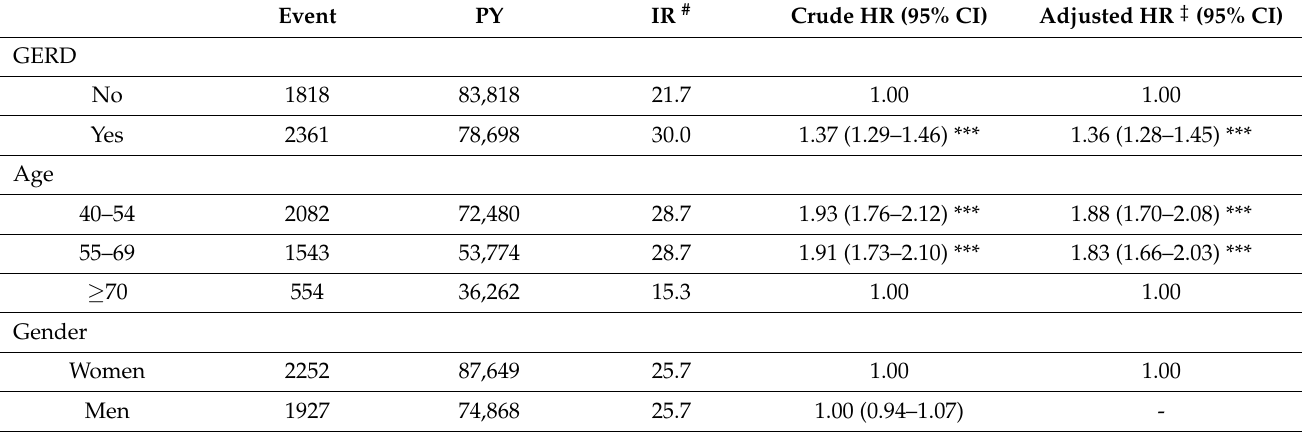
Table 3. Incidence rates and hazard ratios of periodontitis for individuals with and without GERD.